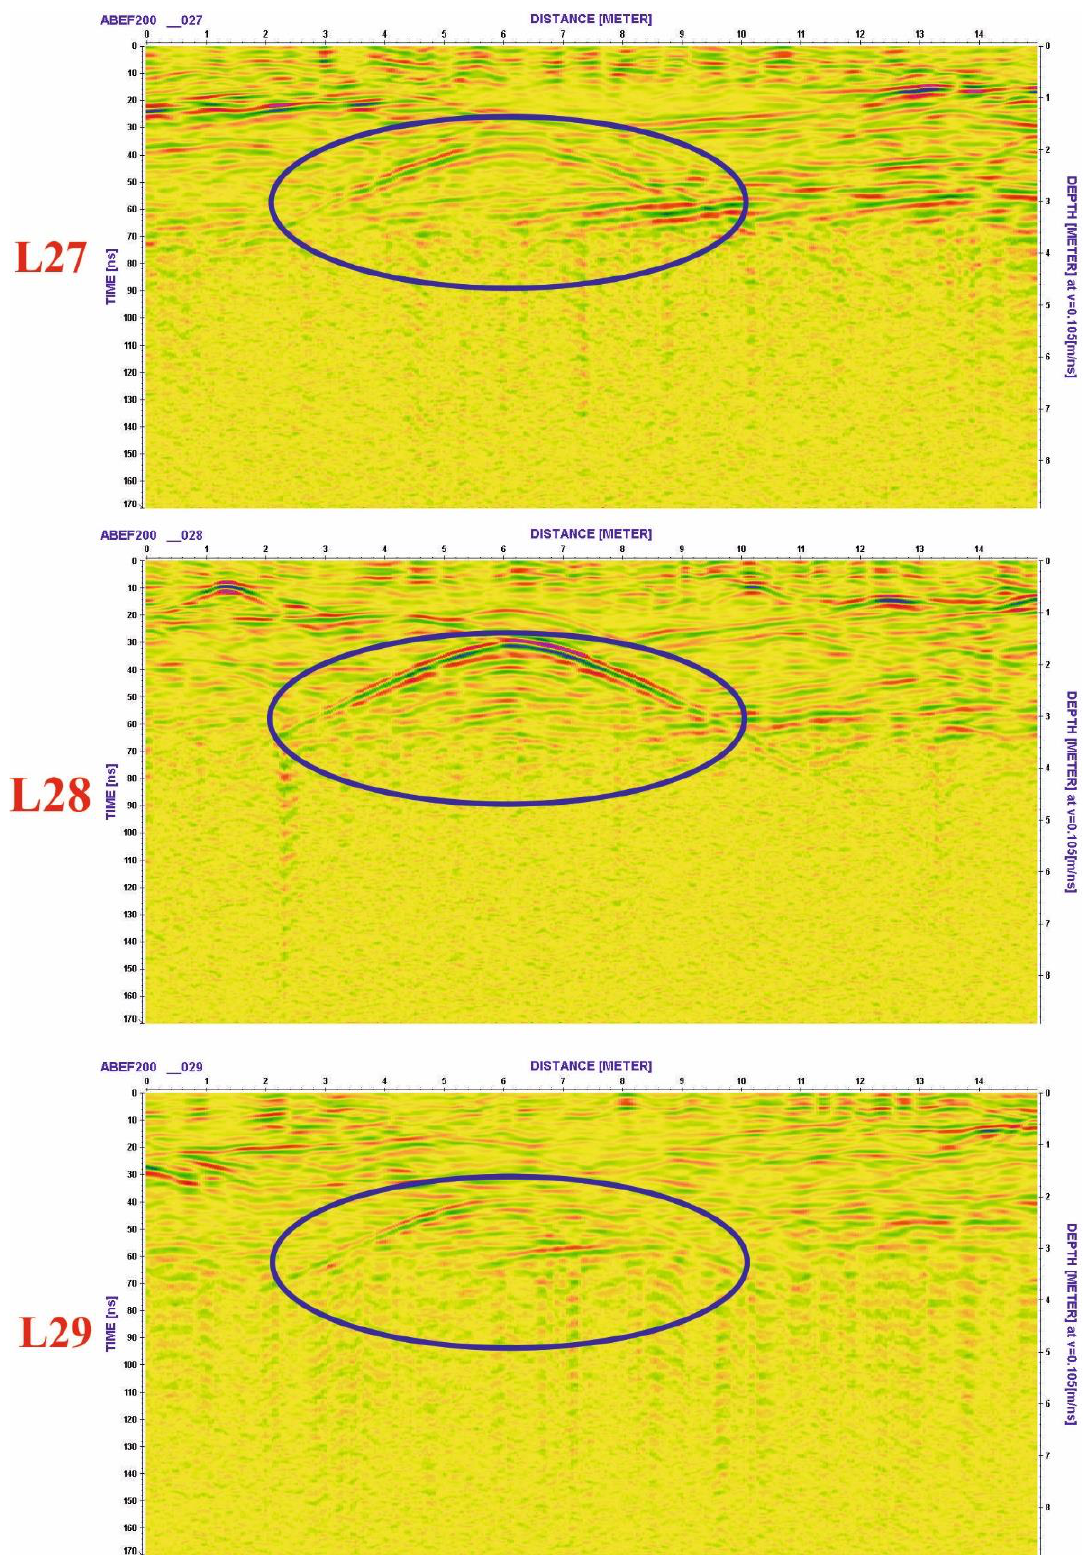
Figure 8. Radargram sections of three successive inline profiles (L27, L28 and L29) executed on grid No. (3) during detailed survey in Abydos site. Their lengths are 15 m. These sections show the same hyperbolic shape indicated in the reconnaissance profiles with the same dimension, amplitude and depth. It was shown in the blue circle.